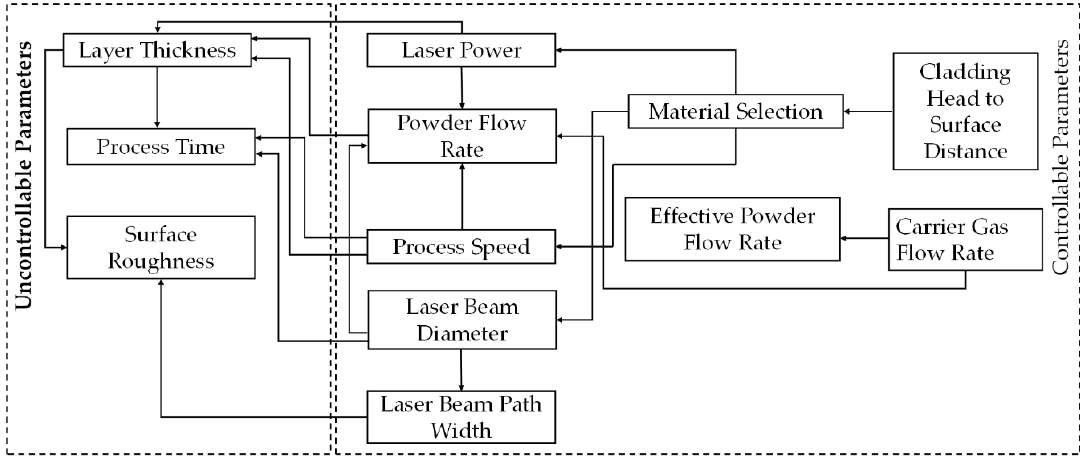
Figure 3. Process Parameters in the LMD technique; based on the data provided in Ref. [2,62 – 69].